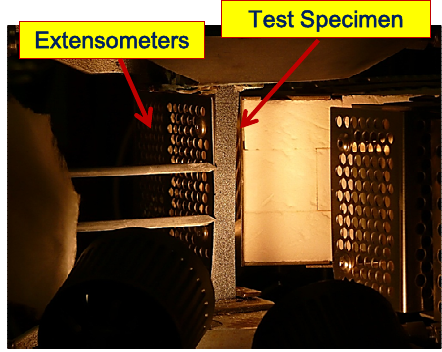
Figure 2. Specimen illuminated by halogen lamps.